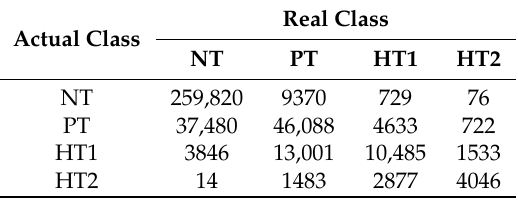
Table 5. The confusion matrix for Random Forest over the Testing